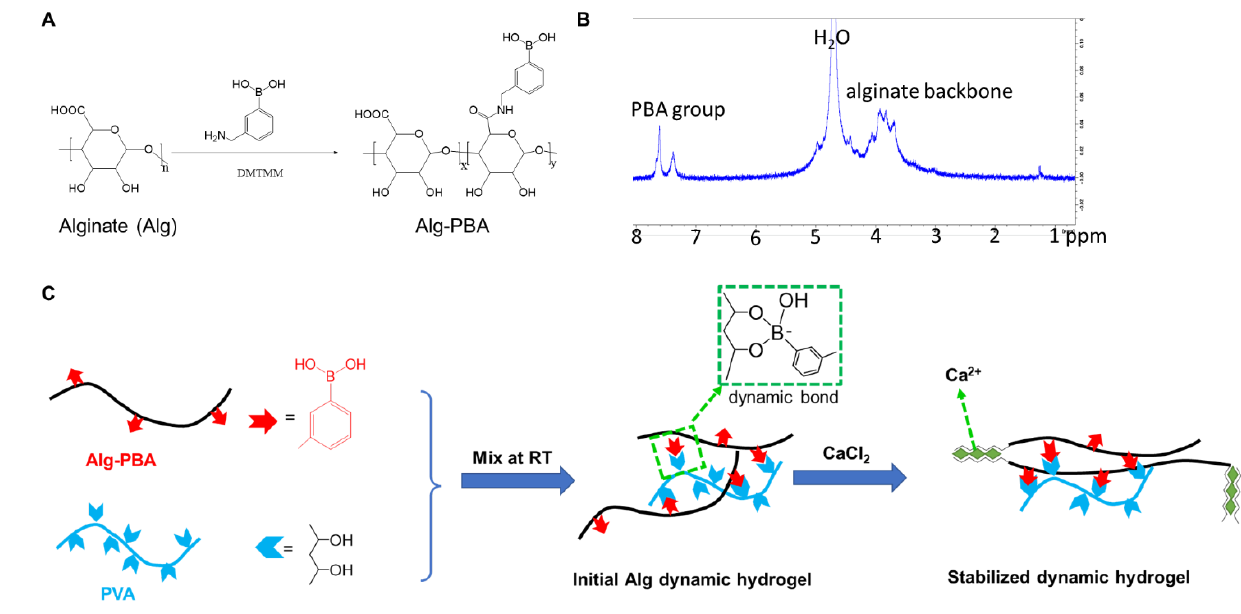
Figure 1. Schematic illustration for preparation of dynamic alginate hydrogel and its stabilization. ( A ) Synthesis strategy of alginate derived with PBA functional group (Alg-PBA); ( B ) 1 H NMR spectra of Alg-PBA; ( C ) schematic representation of formation of dynamic alginate hydrogel stabilized with calcium ions.